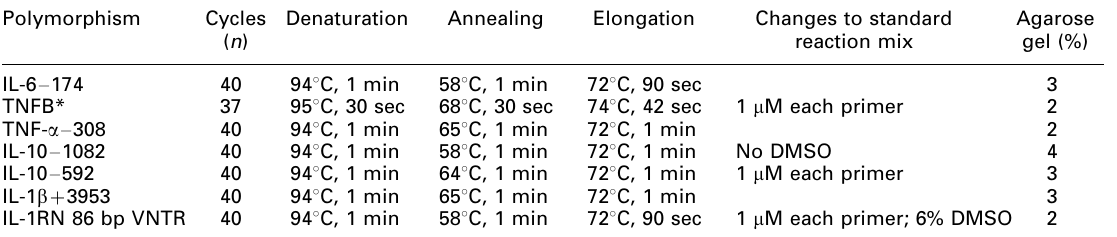
Table 3. PCR cycling parameters, changes to standard reaction mix, and percentage agarose gel used in each assay Polymorphism